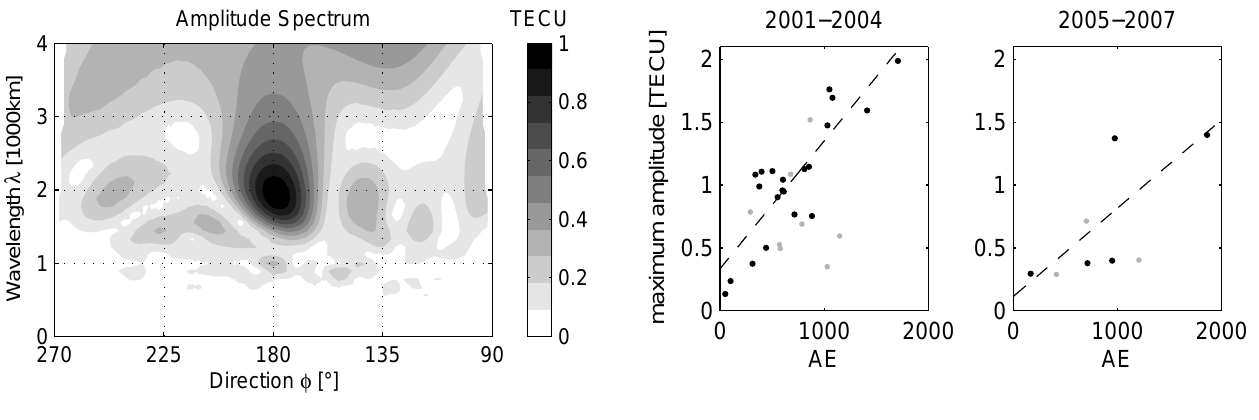
Fig. 3. Amplitude spectrum of the TEC perturbation map 23rd May 2002 12:22 as a result of the 2-D Fourier analysis.